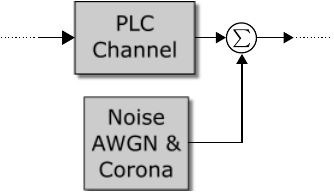
Figure 9. Model of the PLC channel.